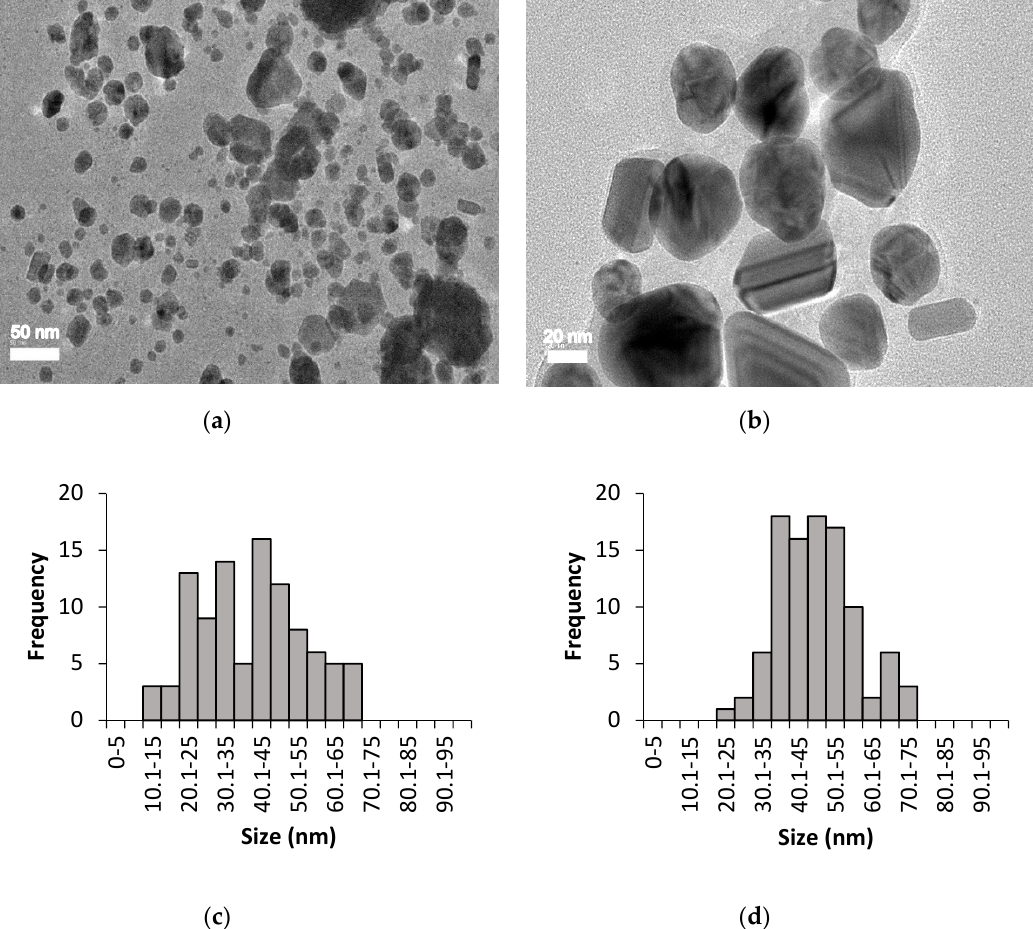
Figure 4. HR-TEM imaging for biologically synthesised AgNPs: ( a ) Uncoated AgNPs, ( b ) PEG-coated AgNPs, ( c ) size distribution of uncoated AgNPs with an average size of 40.26 ± 14.27 nm, and ( d ) size distribution of PEG-coated AgNPs with an average size of 47.36 ± 10.61 nm.